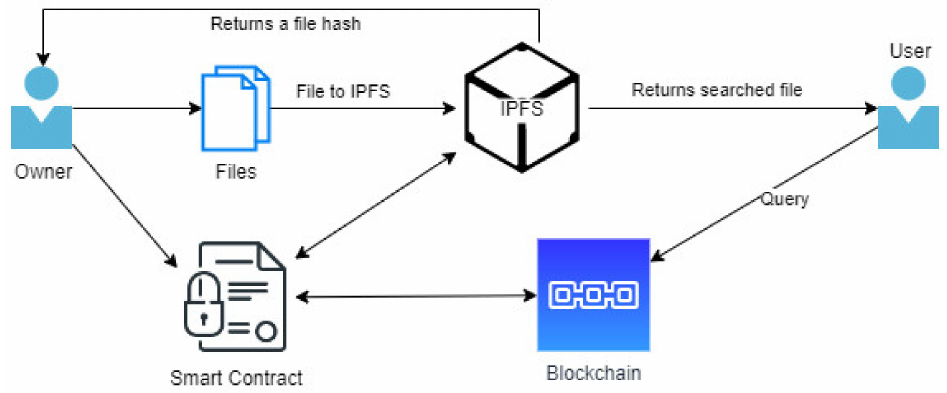
Figure 2. The IPFS for a Smart